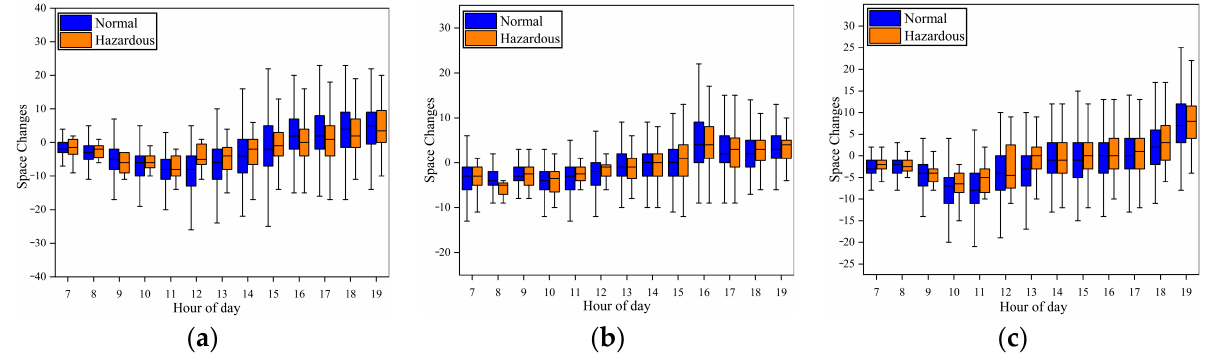
Figure 3. Impact of weather on VPS changes (7 a.m. to 7 p.m.). ( a ) Lot1 parking lot; ( b ) St5 parking lot; ( c ) St7 parking lot.